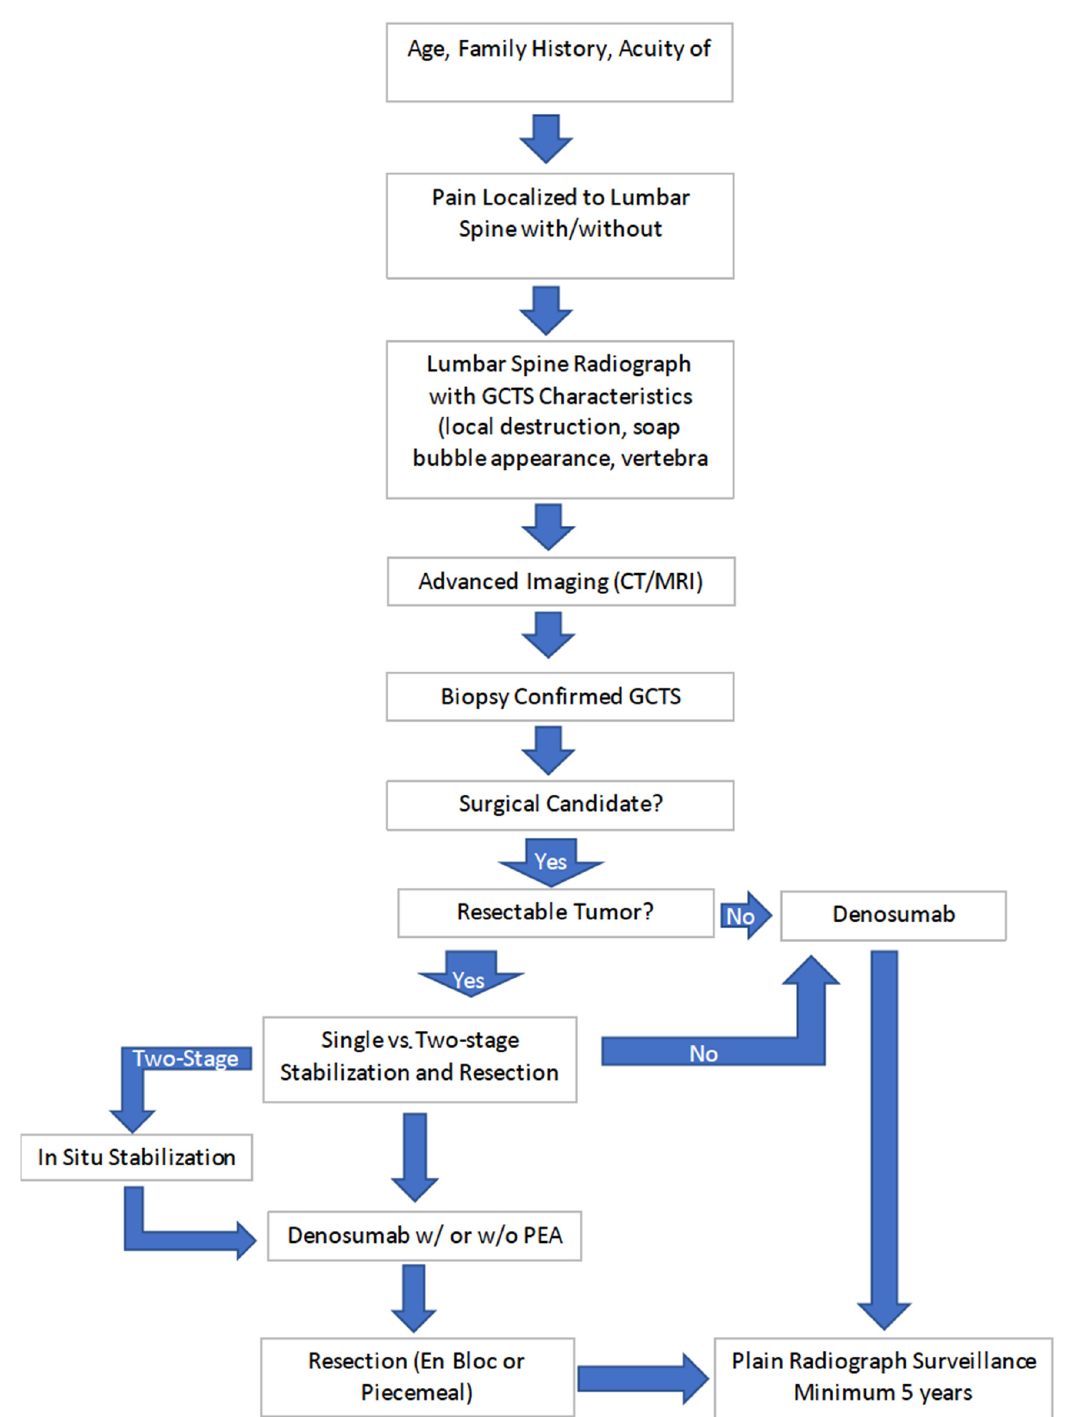
Figure 8. Proposed algorithm for treatment and diagnosis of GCT of the lumbar